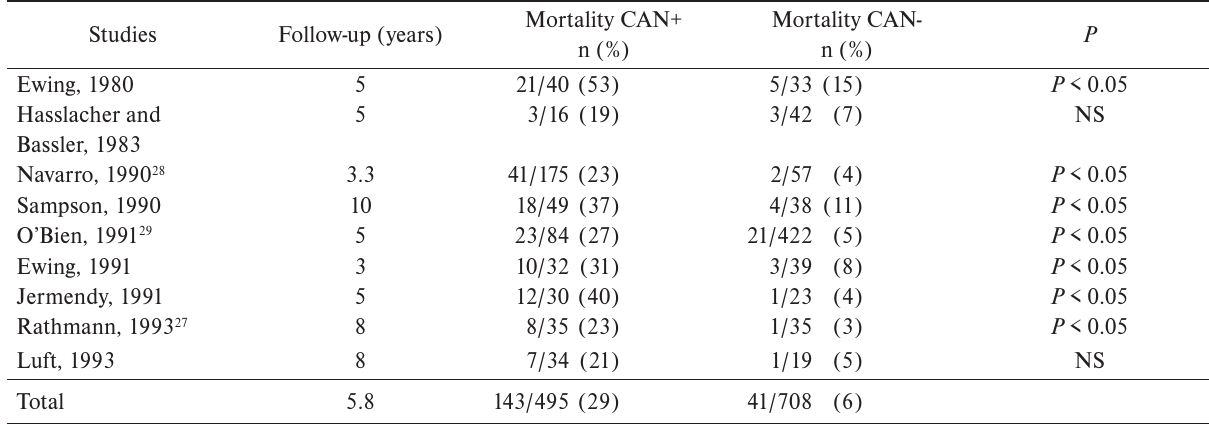
Table 6. Mortality of diabetic patients with/without